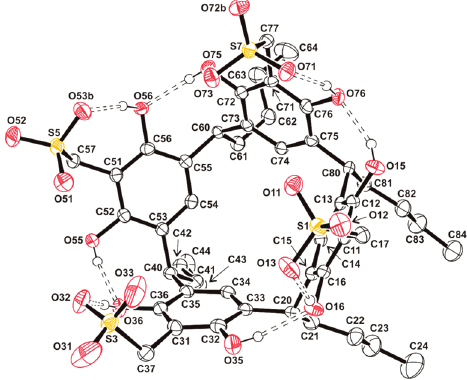
Figure 3. Resorcinarene moiety of 2a (thermal ellipsoids at the 50% probability level). Methyl, methylene, methine and aromatic hydrogen atoms are omitted for clarity. Relevant hydrogen interactions are showed. Symmetry code: (b) − x + 1, − y , − z +